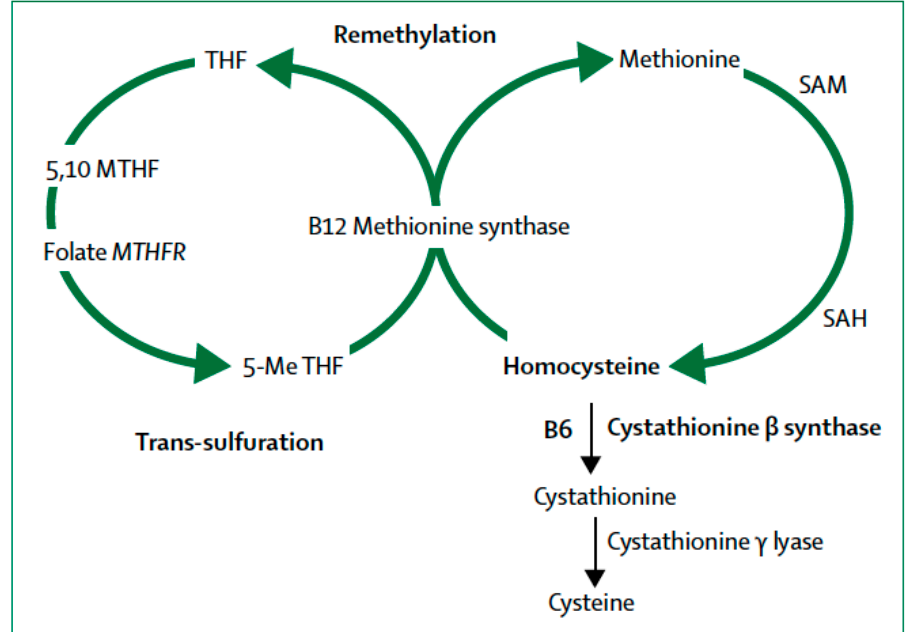
Figure 1. Homocysteine metabolism: B12 = cobalamin (vitamin B12). B6 = pyridoxine (vitamin B6). MTH = methylenetetrahydrofolate. MTHFR = methylenetetrahydrofolate reductase. SAM = S-adenosyl- methionine. SAH = S-adenosylhomocysteine. 5-Me THF = 5-methyl tetrahydrofolate. (From [53]).